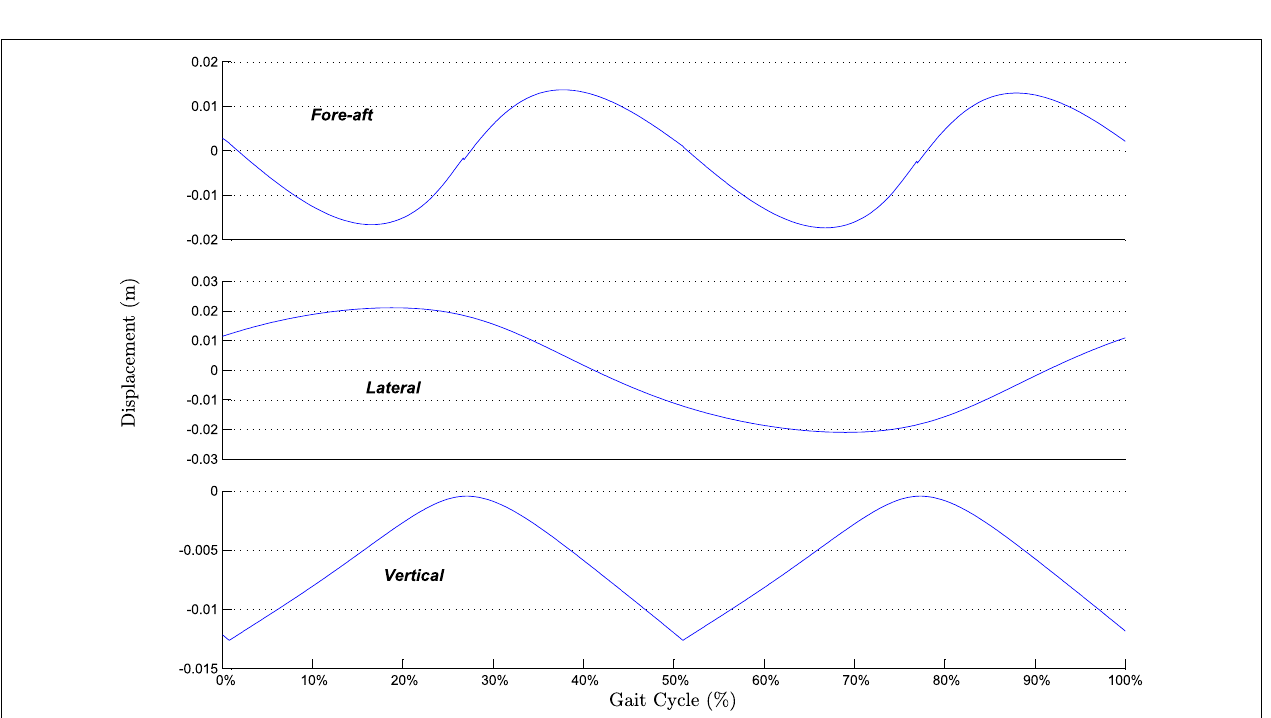
FIGURE 11 | CoM displacement as a result of the gait generation approach developed using the SIP control framework .